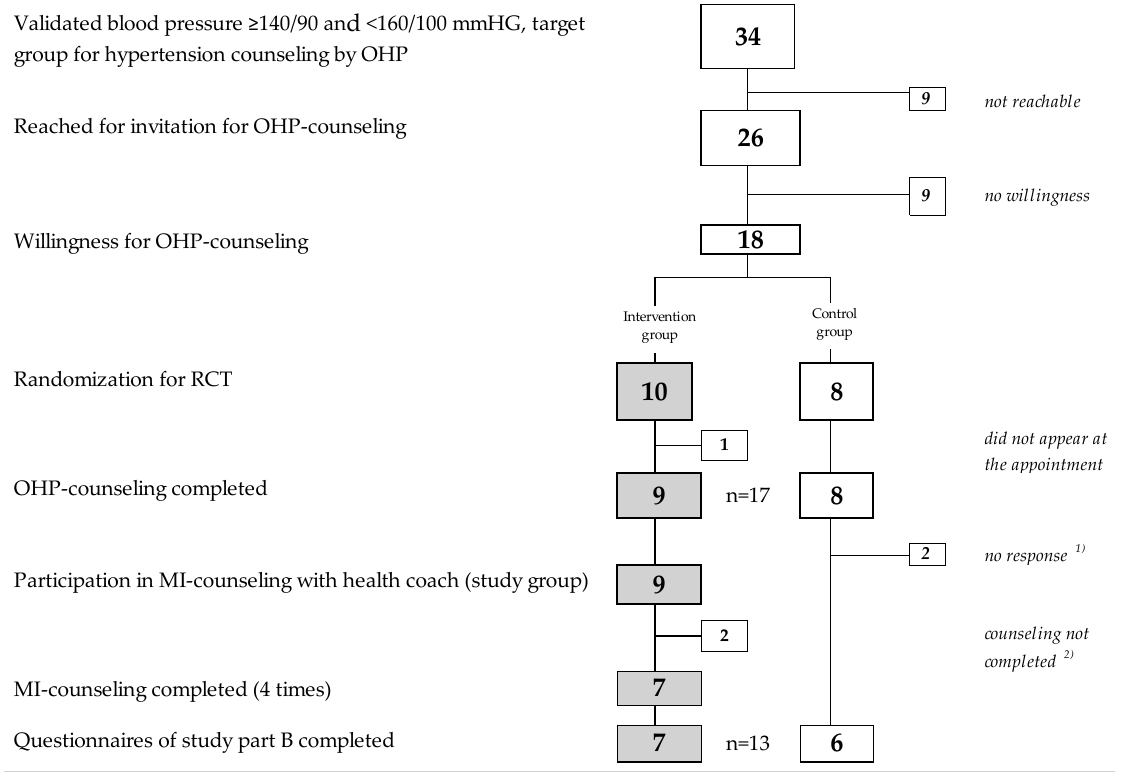
Figure 3. Participants in Study Part B (intervention with randomized controlled trial (RCT) study design). Legend: 1) to complete T5 questionnaire after telephone reminder; 2) not reached any more.